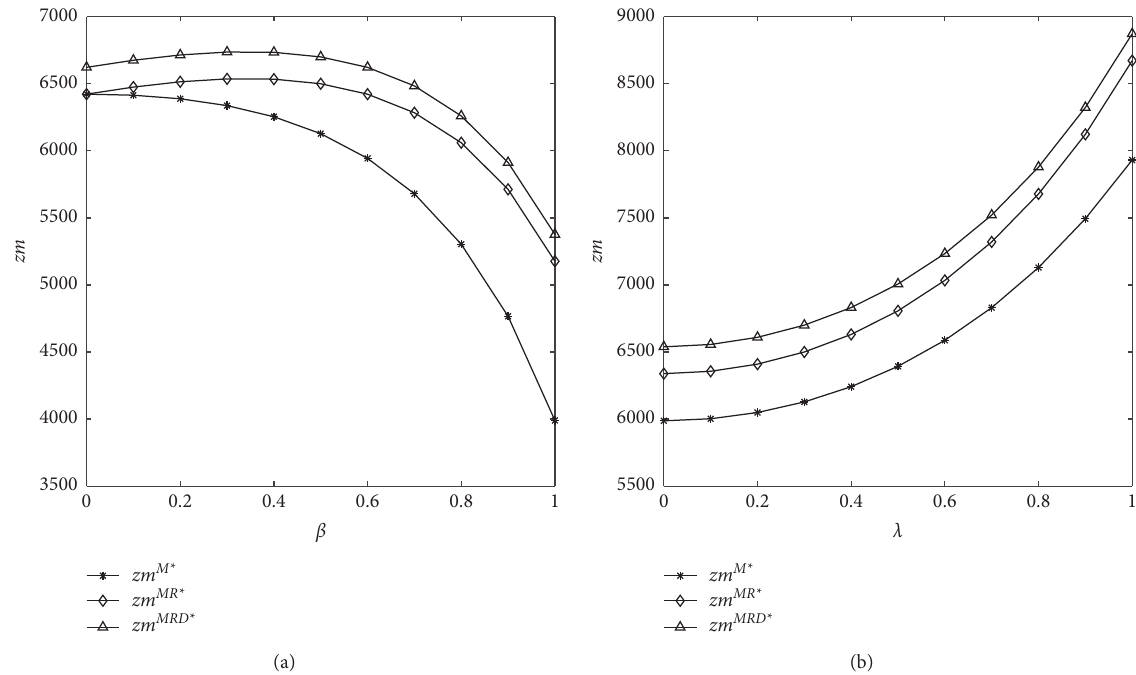
Figure 4: The effect of β and λ on the manufacturer’s